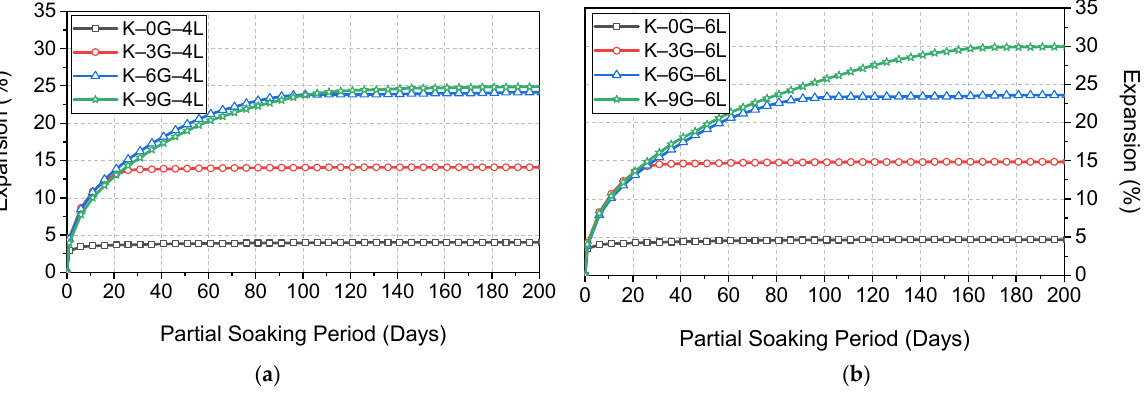
The typical expansion trends, over a longer soaking period of 200 days, for kaolin specimens made with different gypsum concentrations (0, 3, 6, and 9 wt%) and stabilised with two lime dosages (4 and 6 wt%), are shown in Figure 6.